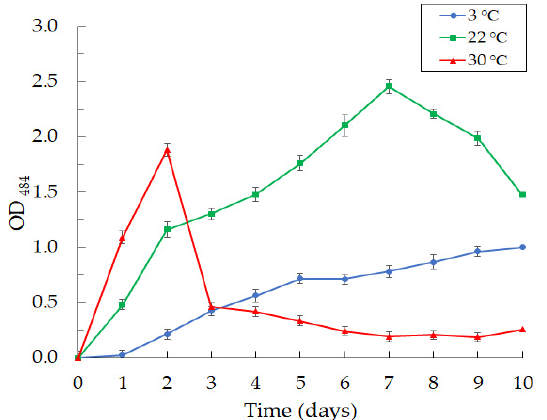
Figure 7. The curves of biofilm formation by Janthinobacterium sp. SLB01 strain at 3, 22, and 30 ° С . Results are shown as mean values of three independent experiments performed.